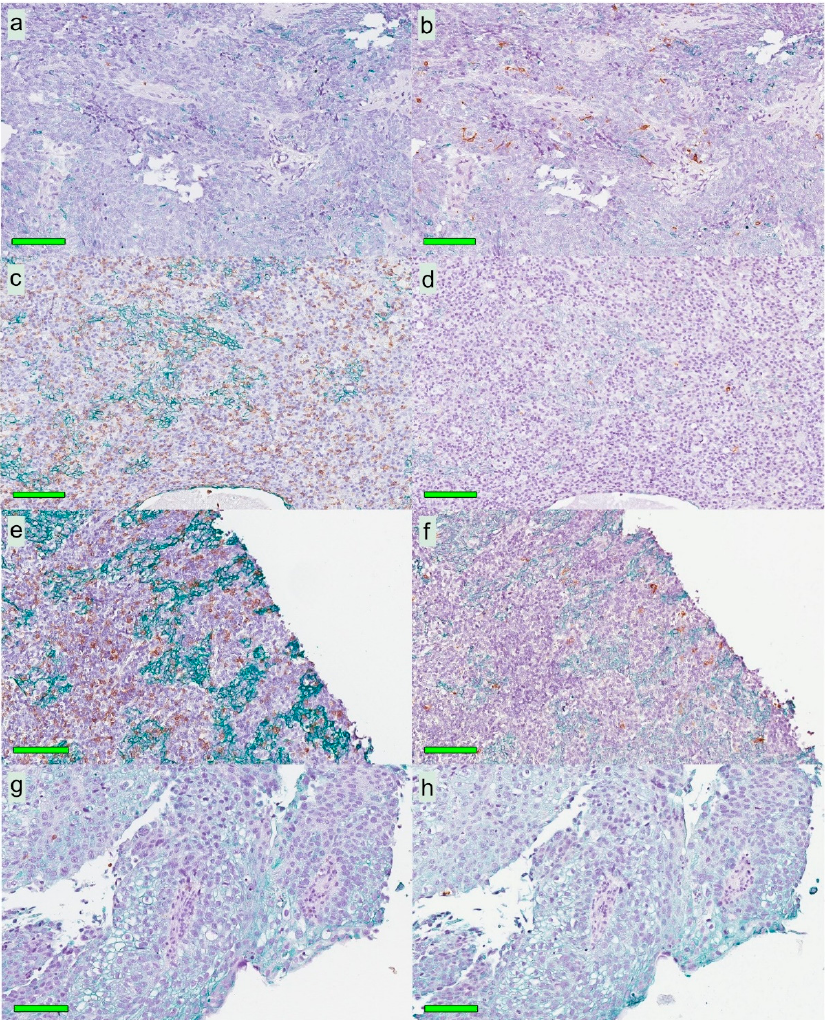
Figure 3. Di ff erent patterns of CD8 + and CD207 + cell distribution in four selected patients: consecutive tissue sections with Mayer’s hematoxylin in combination with CK (green) and either CD8 or CD207 (brown). Left panels indicate the distribution of CD8 + cells, and right panels indicate CD207 + cells on the following section. The patterns shown are ( a , b ) low in CD8 and high in CD207, ( c , d ) high in CD8 and low in CD207, ( e , f ) high in both CD8 and CD207, and ( g , h ) low in both CD8 and CD207. CD8 expression was in general higher than CD207 expression. Green horizontal size-bars indicate 100 µ m. Abbreviations: NPC = nasopharyngeal cancer and CK =